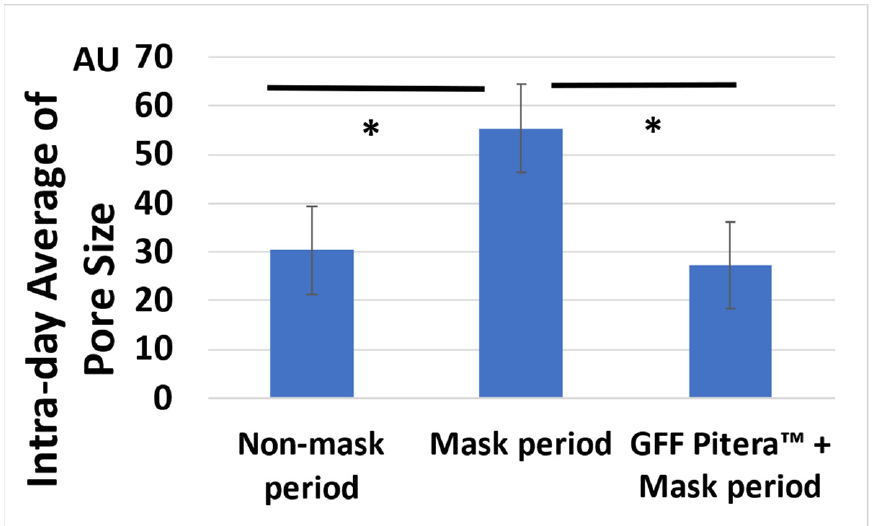
Figure 2. Effect of moisturization on the mask-induced enlargement of pore size. *; p < 0.05. Moreover, the mask-related aggravation of the intra-day ∆ fluctuations in pore size, redness, and TEWL was significantly improved by the topical application of a GFF- containing moisturizer (Figures 3–5). The intra-day ∆ fluctuation in skin hydration was also stabilized at a low level (Figure 3).